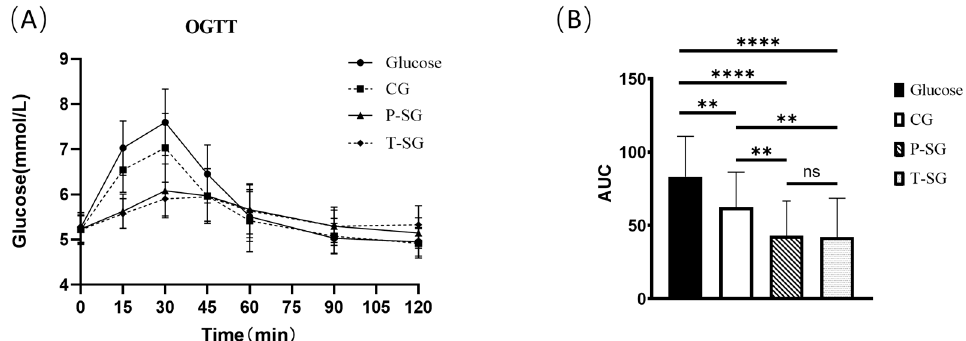
Figure 1. OGTT curve ( A ) and OGTT AUC ( B ) after consumption of 10 g of glucose or three types of nutritional gummies providing equivalent amounts of available carbohydrates. Intragroup comparisons were made using the paired Student’s t test. ****, p < 0.0001; **, p < 0.005; ns, no significant difference. T-SG: total sugar substitutes gummy; P-SG: partial sugar substitutes gummy; CG: comparison gummy (sucrose-based gummy).